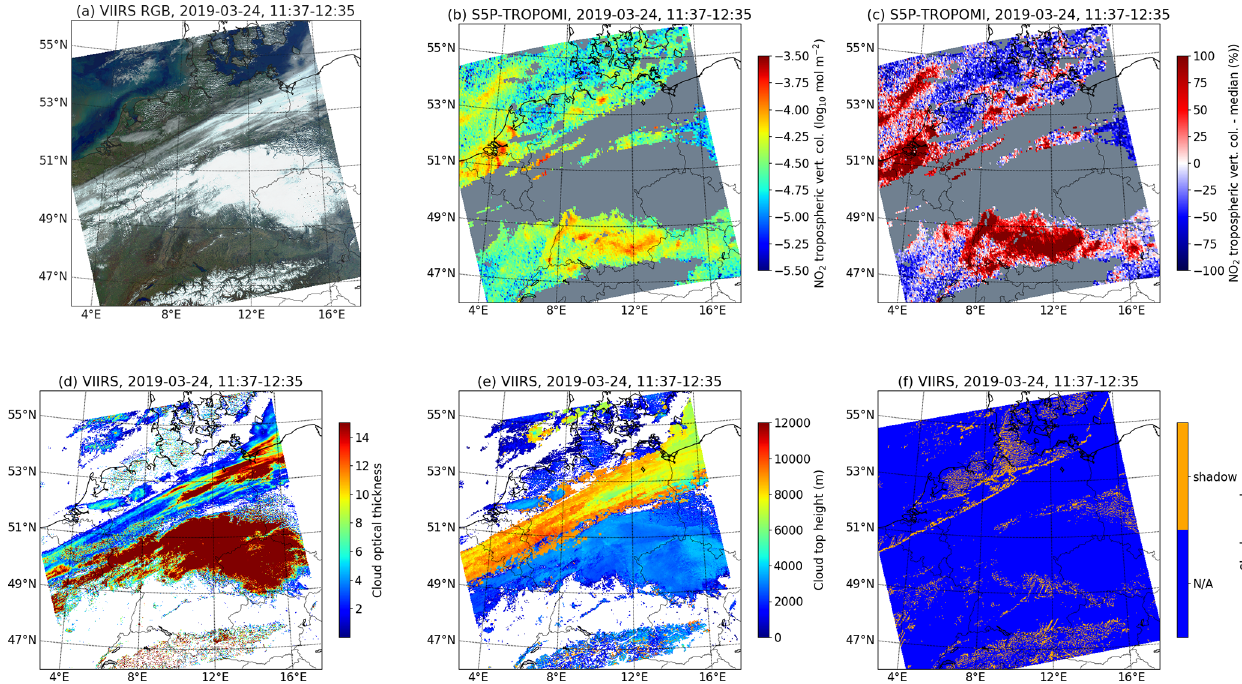
Figure 2. (a) RGB composite of VIIRS bands M3, M4, and M5 (centred at 0.488, 0.555, and 0.672µm). (b) The tropospheric NO 2 vertical column density from TROPOMI. Only pixels with data quality value > 0 . 95 are displayed. (c) The percentage difference of the NO 2 column from the median over the study area. (d) The VIIRS cloud optical thickness. (e ) The VIIRS cloud top height. (f) The VIIRS cloud shadow